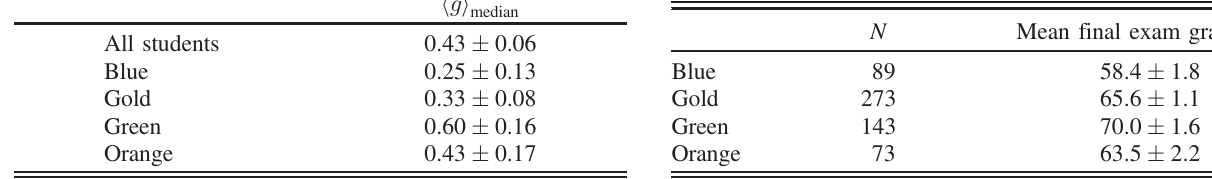
TABLE XI. Mean final exam grade for students with a dominant personality type.